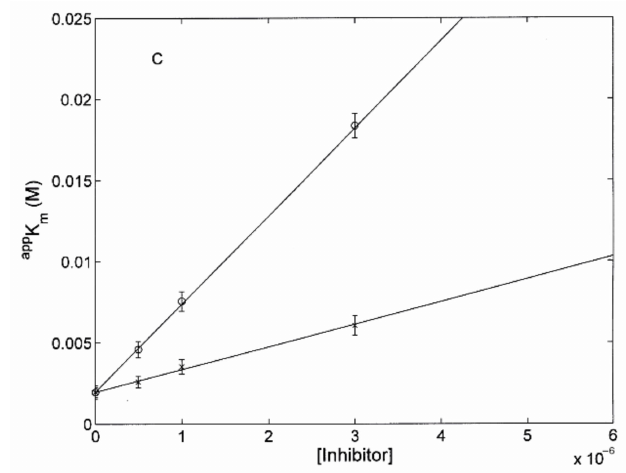
Figure 3. ( A ) Lineweaver–Burk double-reciprocal plot as a function of substrate concentration of h20S ChT-L activity in the absence (o) and in the presence of 0.5 µ ( × ), 1 µ M (+), and 3 µ M (*) H 2 T 4 . Continuous lines are the non-linear least-squares fitting of data according to Equation (1). ( B ) Lineweaver–Burk double-reciprocal plot as a function of substrate concentration of h20S ChT-L activity in the absence (o) and in the presence of 0.5 µ M ( × ), 1 µ M (+), and 3 µ M (*) MTPyApi. Continuous lines are the non-linear least-squares fitting of data according to Equation (1). ( C ) Dependence of K m on the concentration of H 2 T4 (o) and MTPyApi ( × ). Continuous lines are the non-linear least-squares fitting of data according to Equation (2).